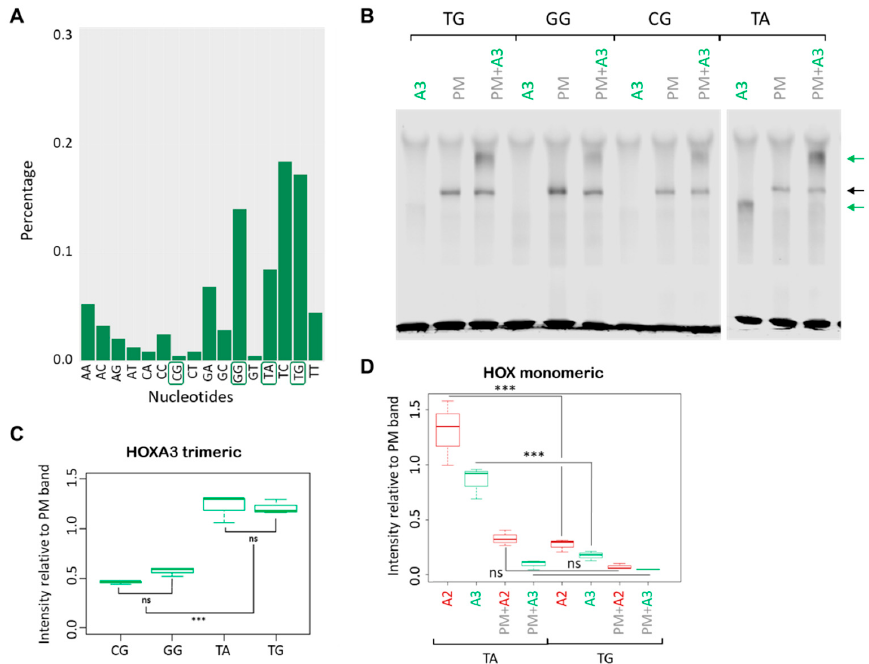
Figure 2. HOXA3 binding to Meis2 probe variants. ( A ) Percentage of TGATNNAT variants (all possible permutations of the NN variable region) in top 250 HOXA3 peaks, ranked by fold enrichment. ( B ) HOXA3 binding to the Meis2 probes containing mutations detailed in Figure 1B, in the presence and absence of PBX/MEIS (PM). Trimeric complex binding is reduced in GG and CG mutants, but TA mutant sees an increase in the binding of monomeric HOXA3. Black arrows indicate PBX/MEIS dimer, green arrows indicate HOXA3 interactions with the probe. ( C ) The quantification of HOXA3/PBX/MEIS bands from experiment in ( B ) (three replicates) shows a reduction in CG and GG mutants relative to the wild type, whereas TA is unchanged. All bands are quantified relative to the wild-type PBX/MEIS band. *** p -value < 0.0005; ns: no significant. ( D ) The quantification of HOXA2 and HOXA3 bands from the experiments in Figures 1C and 2B (three replicates) shows an increase in the binding of monomeric HOX to the TA probe relative to the wild type.